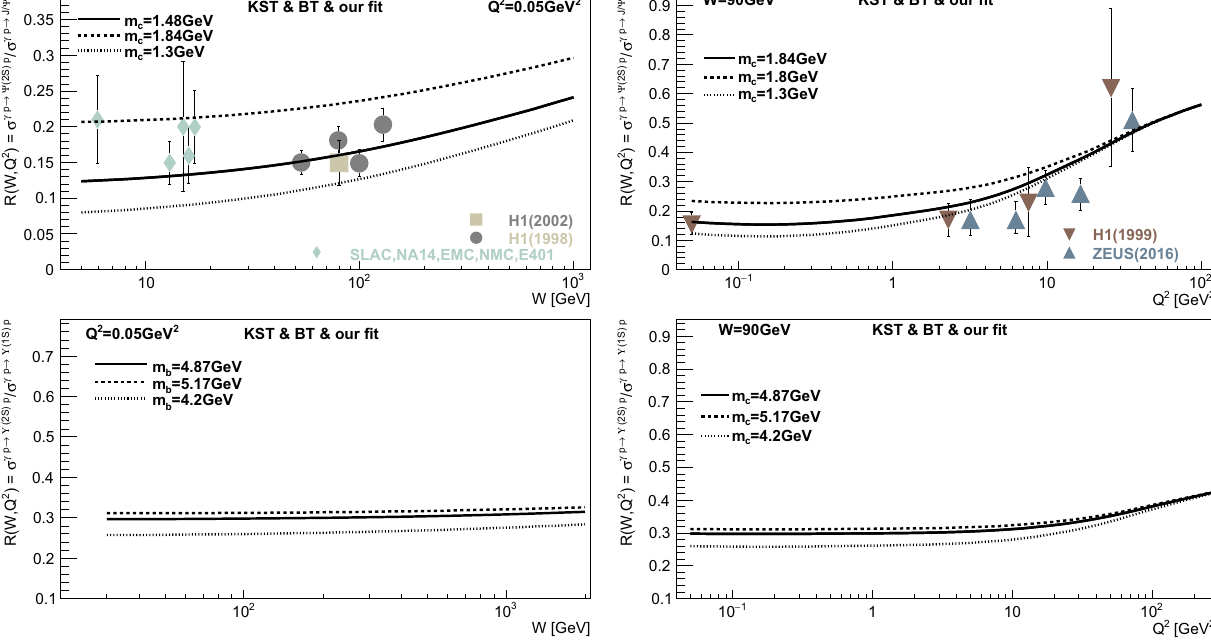
as is shown in J /ψ